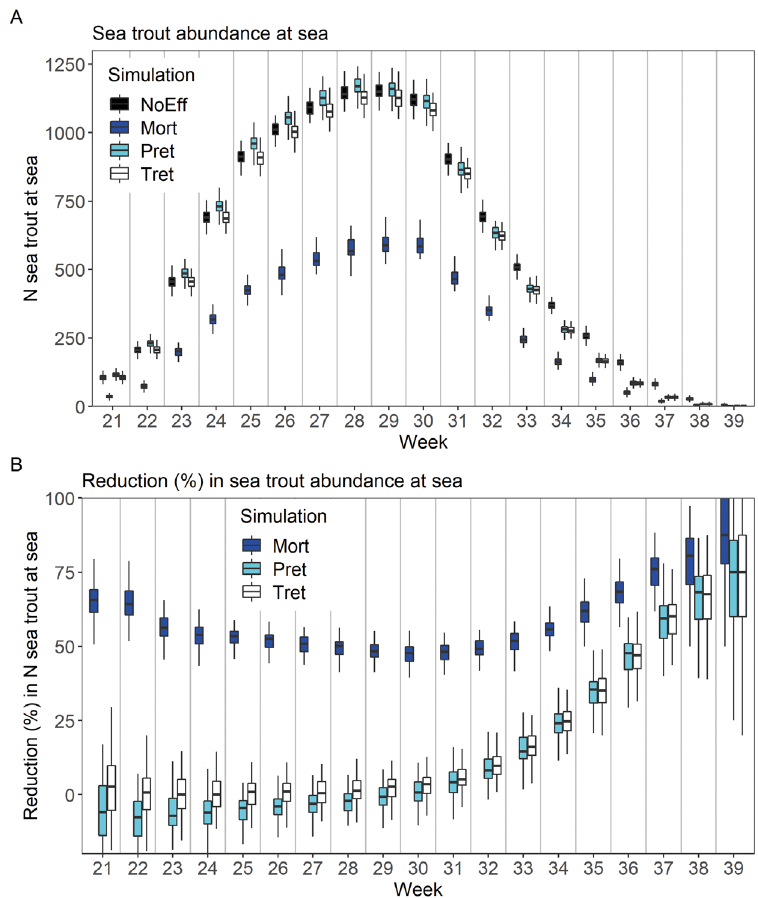
Fig. 5. Intra-annual pattern of (A) abundance of sea trout at sea for simulations with lice effects absent (NoEff), lice-induced mortality (Mort), lice-induced persistent premature return (Pret) and lice-induced transitory premature return (Tret), and (B) reduction (%) in abundance from simulation with